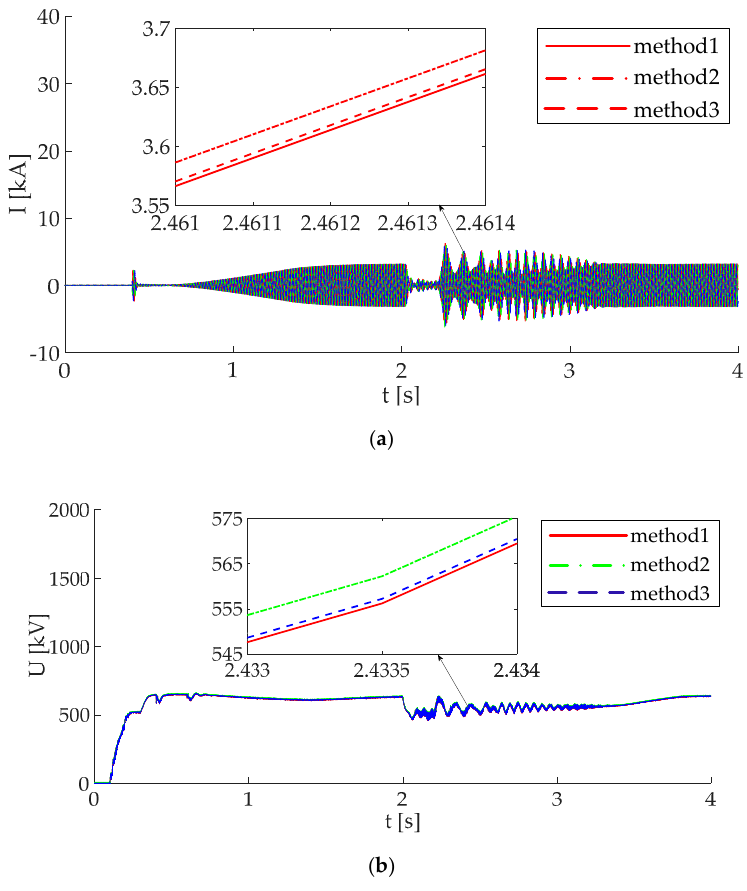
Figure 8. The three phase ground fault in converter bus 3. ( a ) The AC current. ( b ) The DC voltage. (b) The ground fault in DC line